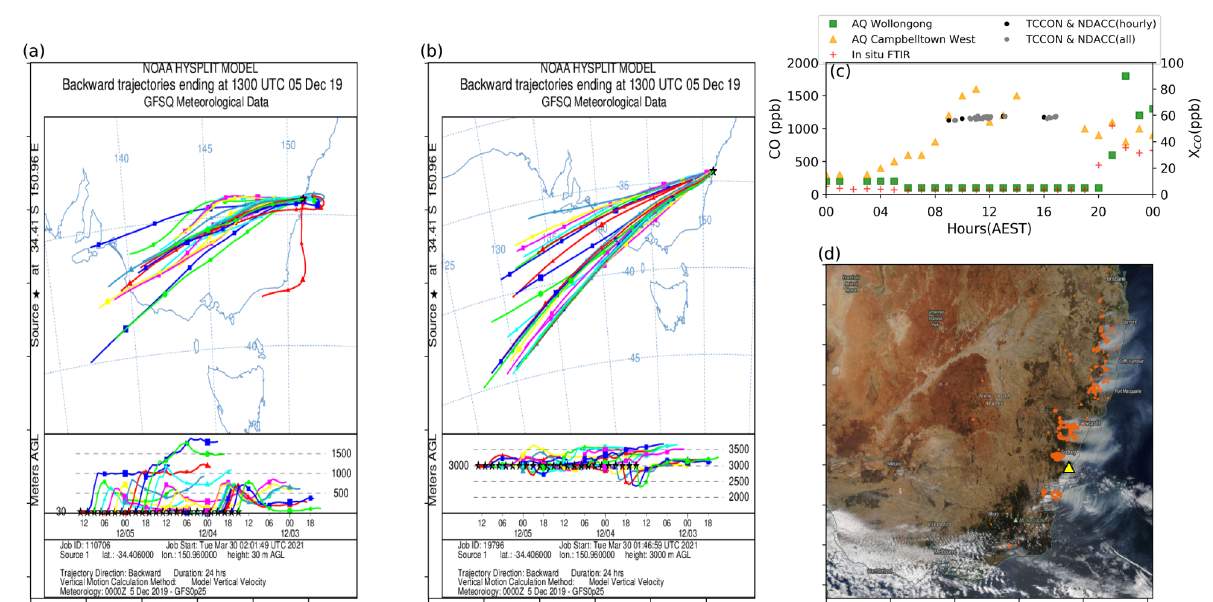
Figure 11. 5 December 2019: 24 h NOAA HYSPLIT back trajectories (UTC) at ( a ) 30 m and ( b ) 3000 m; ( c ) Hourly averaged surface in situ CO measurements at Wollongong air quality monitoring site (green squares), Campbelltown West air quality monitoring site (yellow triangles) and Wollongong in situ FTIR (red crosses). Black and grey dots show hourly averaged column CO measurements (TCCON & NDACC) and all native temporal resolution column measurements, respectively (in AEST: UTC + 10 h). ( d ) MODIS hotspot image with thermal anomalies [68] (zoomed in for southeast Australia). The UOW measurement site is marked with a yellow